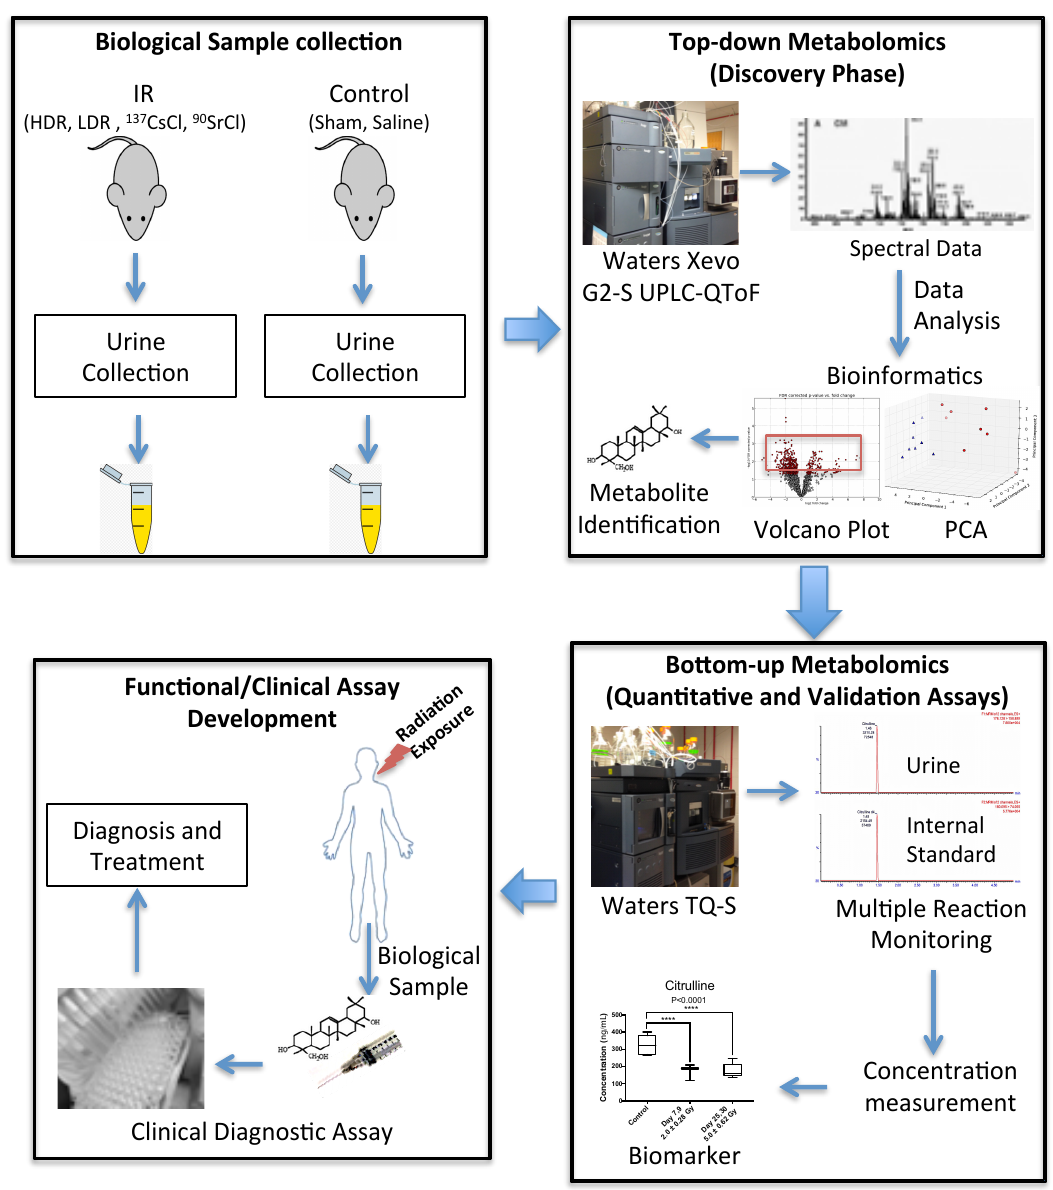
Figure 7. Overview of the untargeted and the quantitative studies. Urine samples were collected at indicated time points from mice exposed to various IR sources; internal 90 Sr, internal 137 Cs, X-ray HDR, and X-ray LDR The samples were initially subjected to untargeted metabolomic profiling using Waters Xevo G2-S UPLC-QToF (Waters, Milford, MA, USA). The acquired data were deconvoluted and analyzed using various bioinformatics tools. A panel of statistically significant metabolite markers were selected based on their clear IR responses, robustness of responses, magnitude of responses, and biological importance. Citrulline and calcitroif acid matched these criteria and thus were selected for quantitative assessment using Waters tandem quadrupole TQ-S. Multiple reaction monitoring methods were developed with the help of appropriate internal standards. The results of such quantitative study are promising as they have the potential to be